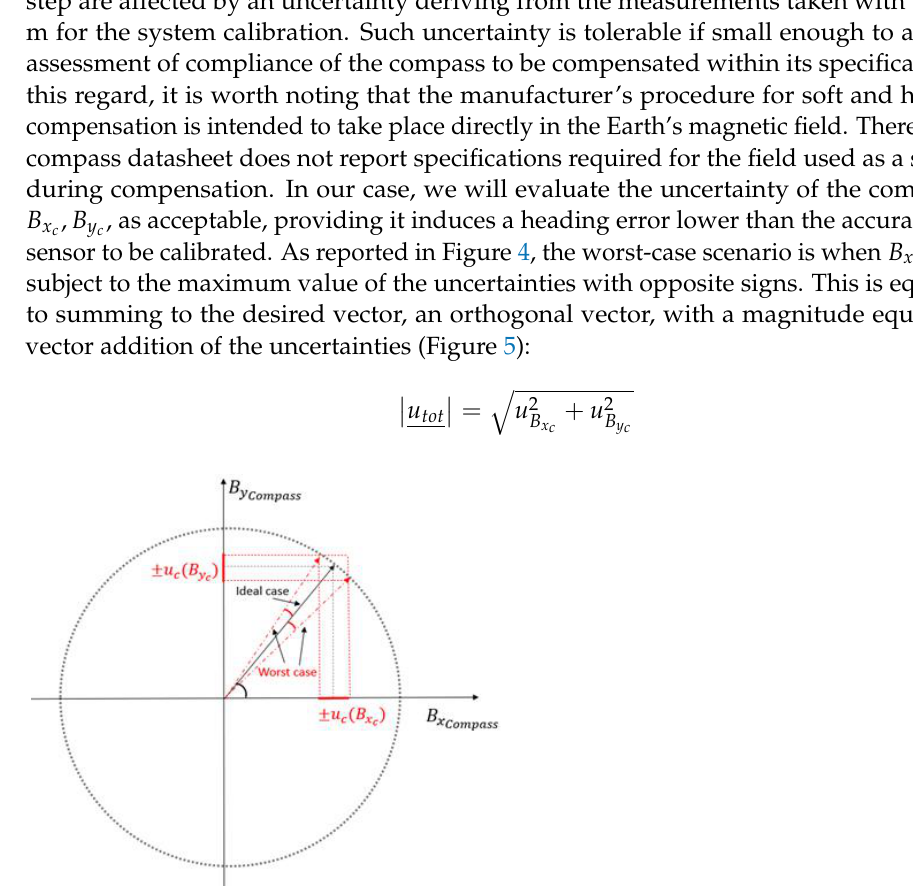
Figure 4. The worst-case scenario is reached when 𝐵 𝑥 nominal plus (minus) 𝑢 𝑐 (𝐵 𝑥